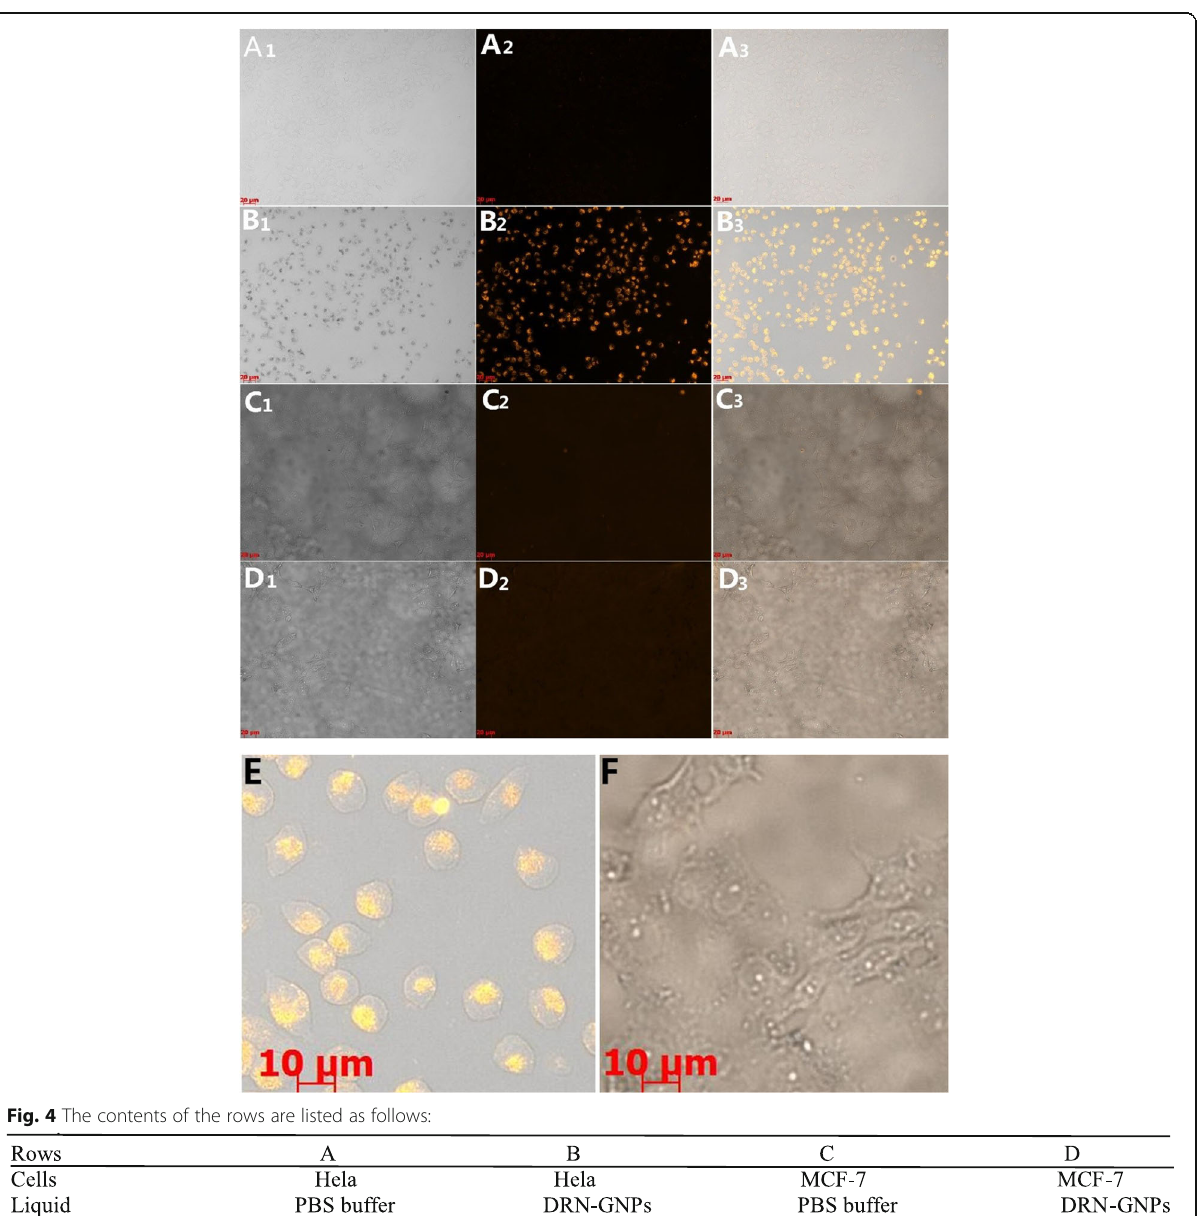
“ PBS buffer ” represents the cells incubate with PBS buffer, “ DRN-GNPs ” represents the cells incubate with DRN-GNPs. The subscript of “ 1 ” represents the bright field images of cells, “ 2 ” represents the dark field images of cells, and “ 3 ” represents the overlapping images (bright-field and dark-field) of cells. All of the scale bars are 20 μ m. The picture of E is a small region chosen from B 3 in Fig. 4, the picture of F is a small region chosen from D 3 in Fig. 4, the scale bars are 10 μ